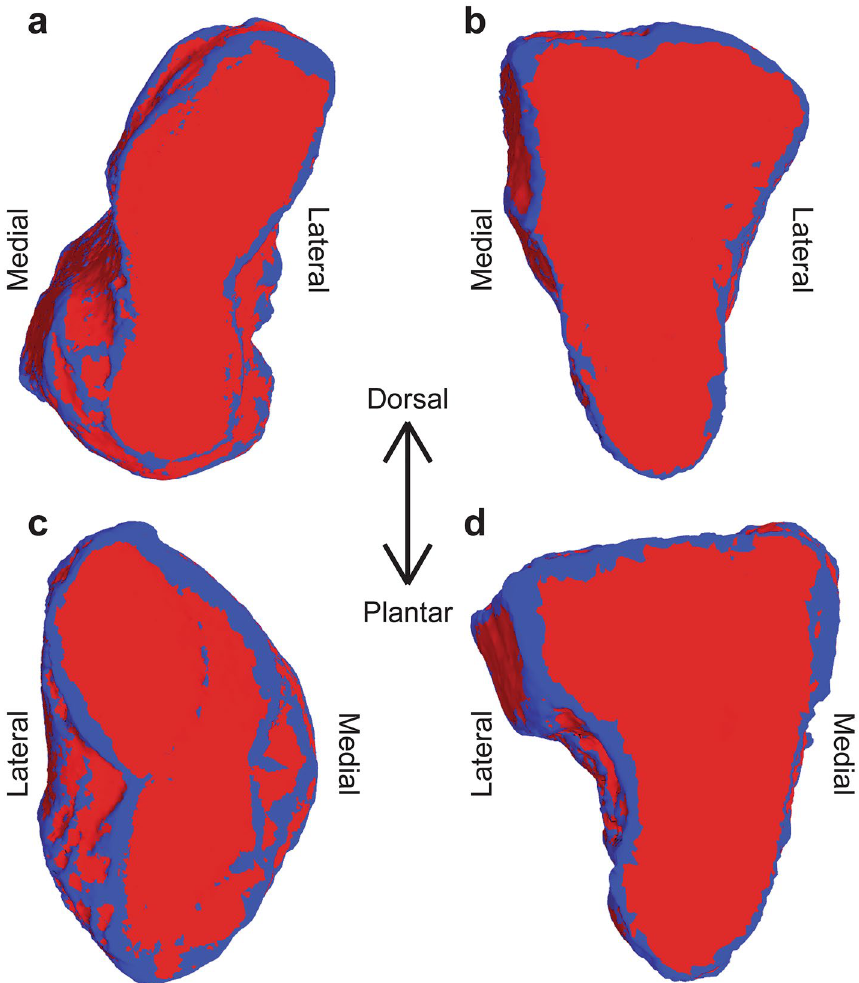
Figure 1. Second-principal curvature identification of the distal articular surfaces of the ( a ) medial cuneiform and ( b ) intermediate cuneiform and proximal articular surfaces of the ( c ) first metatarsal, and ( d ) second metatarsal. Blue shows areas with second-principal curvature below the threshold value and red shows values above that